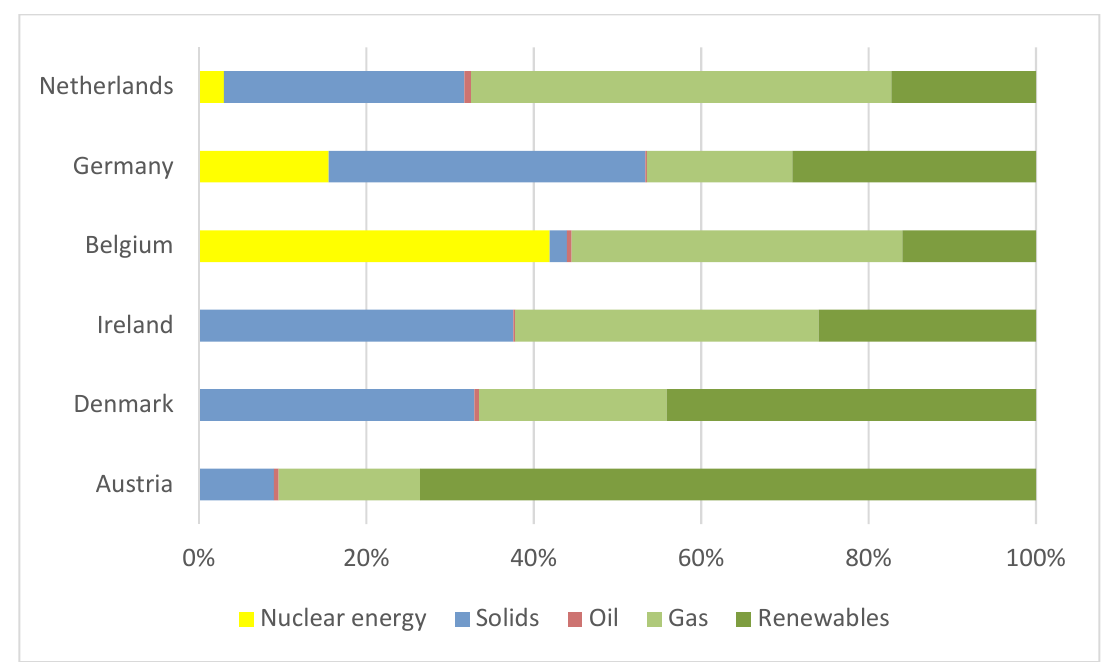
Figure 10. Structure of energy mixes for the fifth cluster . Source (own elaboration).